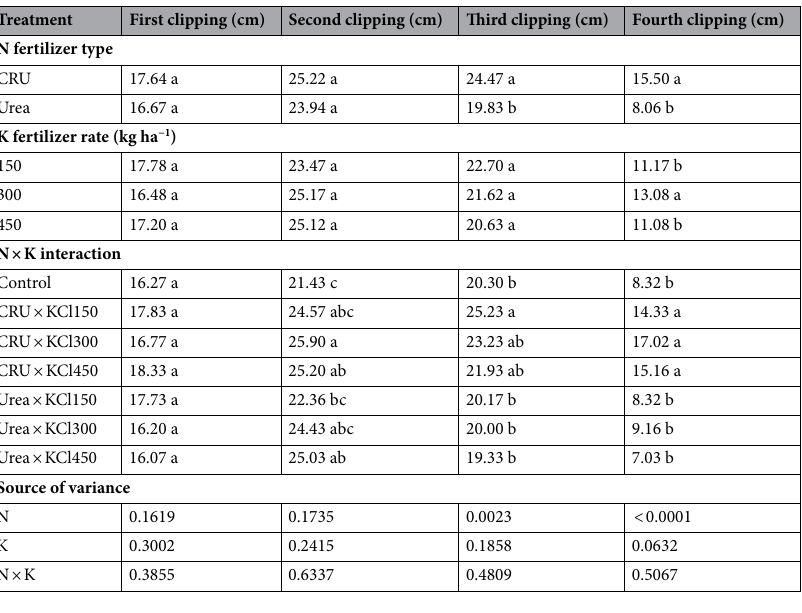
Table 1. The plant height of Italian ryegrass. Means followed by different lowercase letters in the same column were significantly different based on analyses with ANOVAs followed by Duncan tests ( P < 0.05). Control no N and K fertilizer, CRU controlled-release urea, KCl potassium chloride.